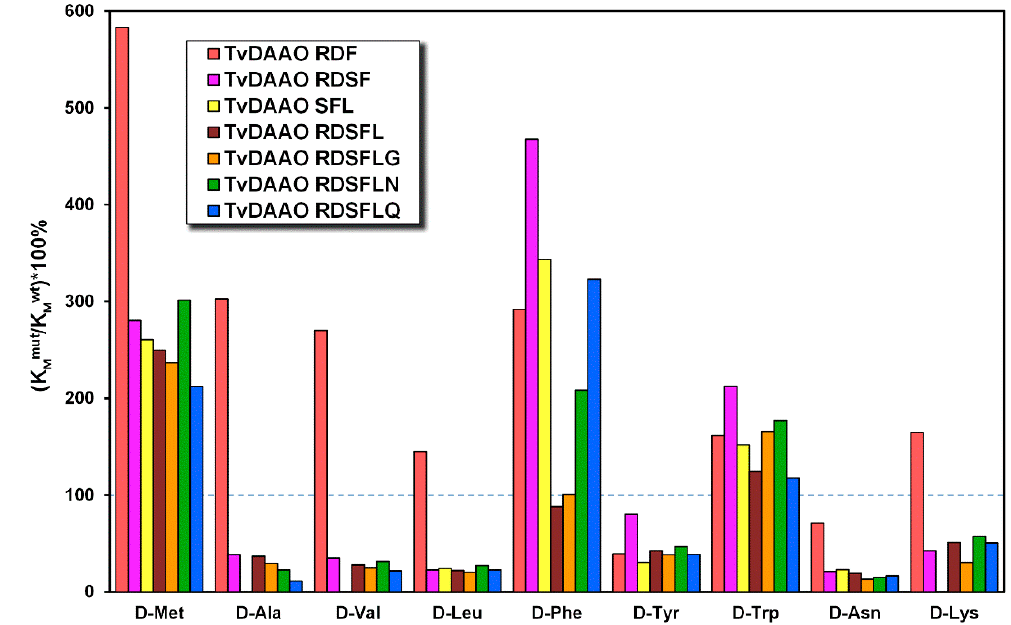
Figure 4. Relative change in Michaelis constants (( K M mut / K M wt )*100%) of TvDAAO mutants. The Michaelis constant of the wild-type enzyme was taken as 100% and indicated by the blue dashed line (0.05 M potassium phosphate buffer pH 8.0, 30 °C, air saturated).